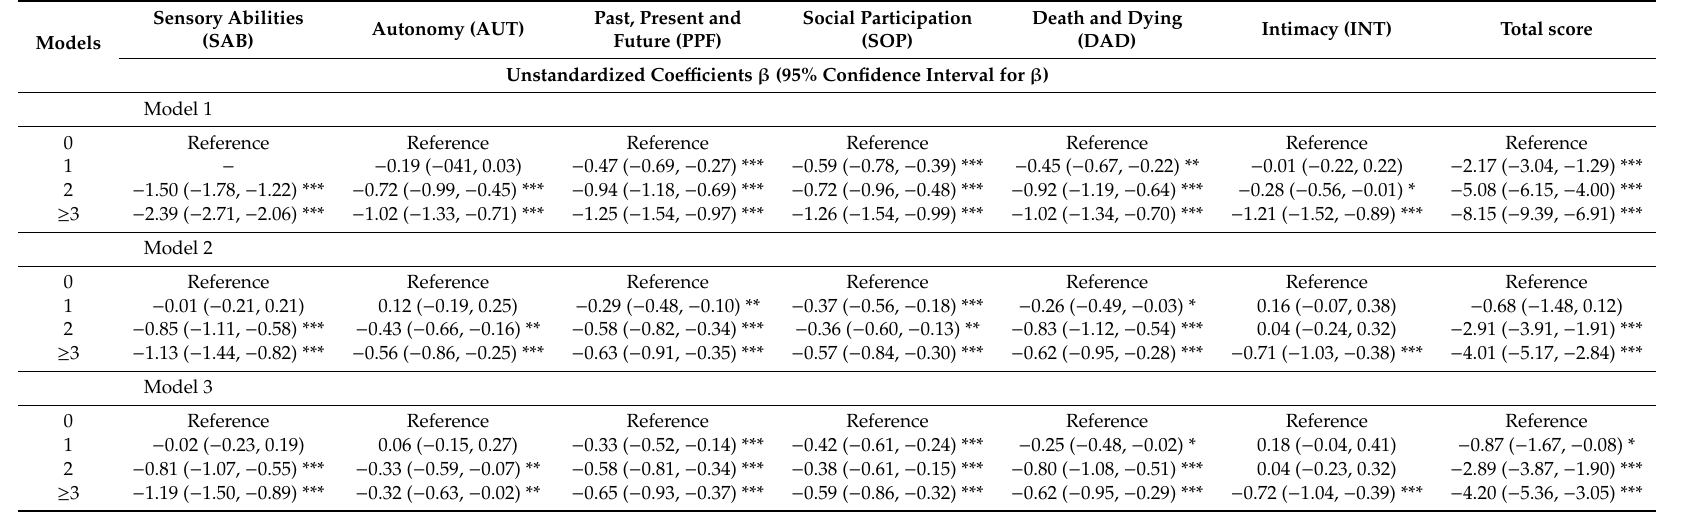
Table 3. Relationship between the number of NCDs and WHOQOL-OLD scale